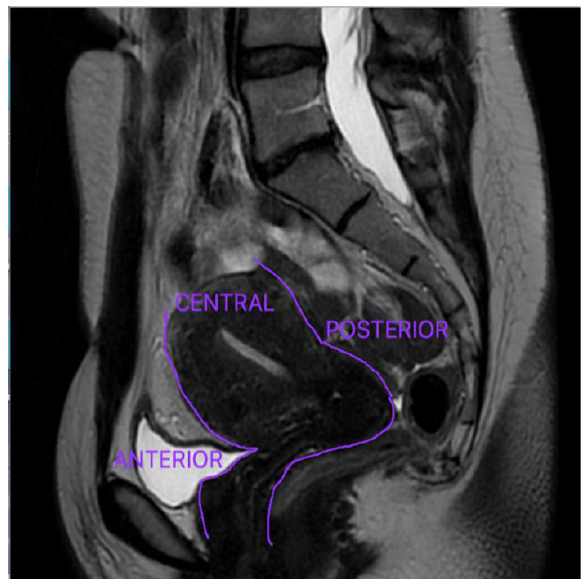
Figure 2. the anterior, central, and posterior pelvic compartments. Figure 2. The anterior, central, and posterior pelvic